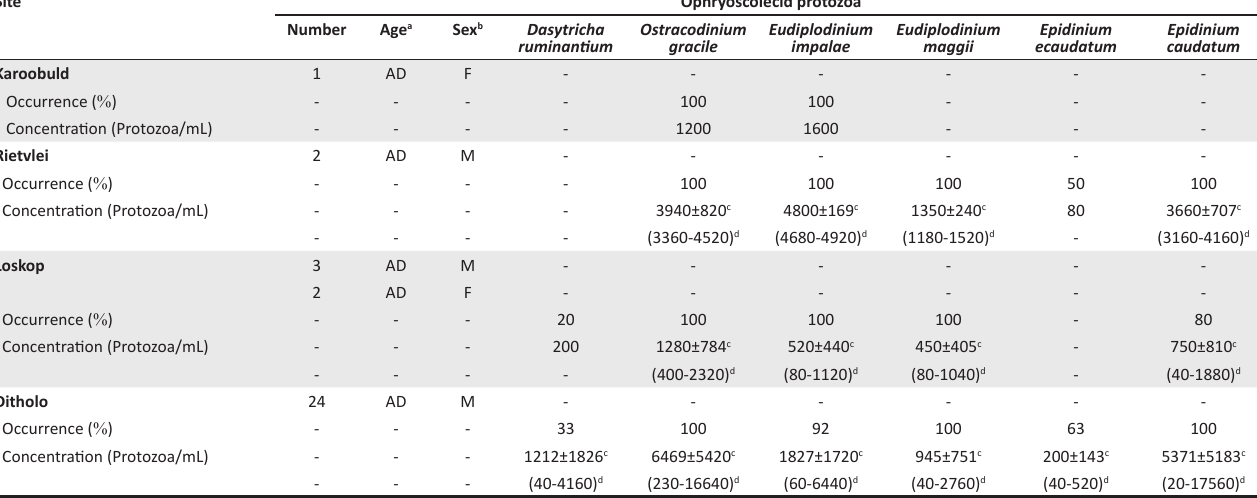
TABLE 2: Occurrence and concentration of Dasytricha ruminantium and larger ophryoscolecid protozoa in rumen contents of the impala.